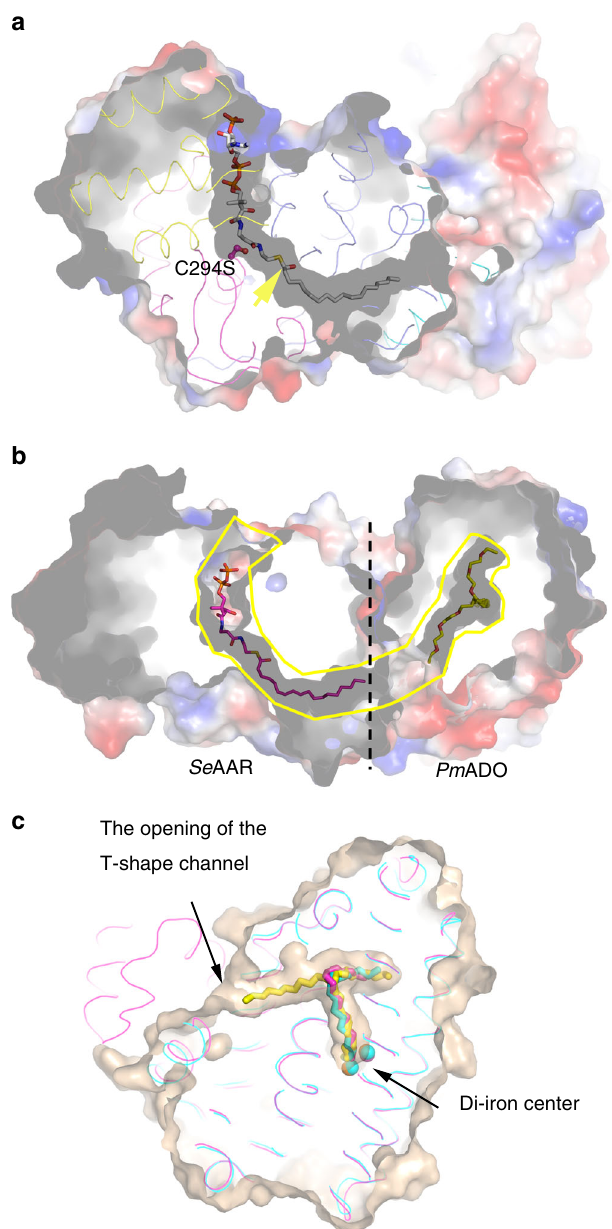
Fig. 4 The AAR stearoyl-CoA – ADO structure. a Surface representation of AAR stearoyl-CoA – ADO structure. Stearoyl-CoA is located in the L-shaped channel and shown as sticks. The residue C294S is not able to form thioester bond with the C1 atom (indicated by yellow arrow) of the stearic chain and is ~6 Å away from it. b Surface representation of Se AAR- Pm ADO model. In Pm ADO structure (PDB code 4PGI), two ligands (shown as sticks and colored yellow for the carbon atoms) are together located in the T- shaped channel, which has a big opening at the molecular surface. The tail end of stearic chain in Se AAR (magenta stick) points toward the entrance of the entering tunnel in Pm ADO. The black dashed line indicates the interface between AAR and ADO. The contiguous channel throughout AAR and ADO is highlighted by yellow line. c The superposition of Pm ADO structure (PDB code 4PGI) onto the ADO part of Se AAR- Se ADO structure solved in this study and the free Se ADO structure solved previously (PDB code 4RC5) to show the T-shaped channel. The Pm ADO structure (PDB code 4PGI) is shown in surface mode, and the ligand bound in the T-shaped channel is shown as yellow sticks. The Se AAR- Se ADO structure (colored magenta) and the free Se ADO structure (PDB code 4RC5; colored cyan) are shown in ribbon, with the bound ligand shown as